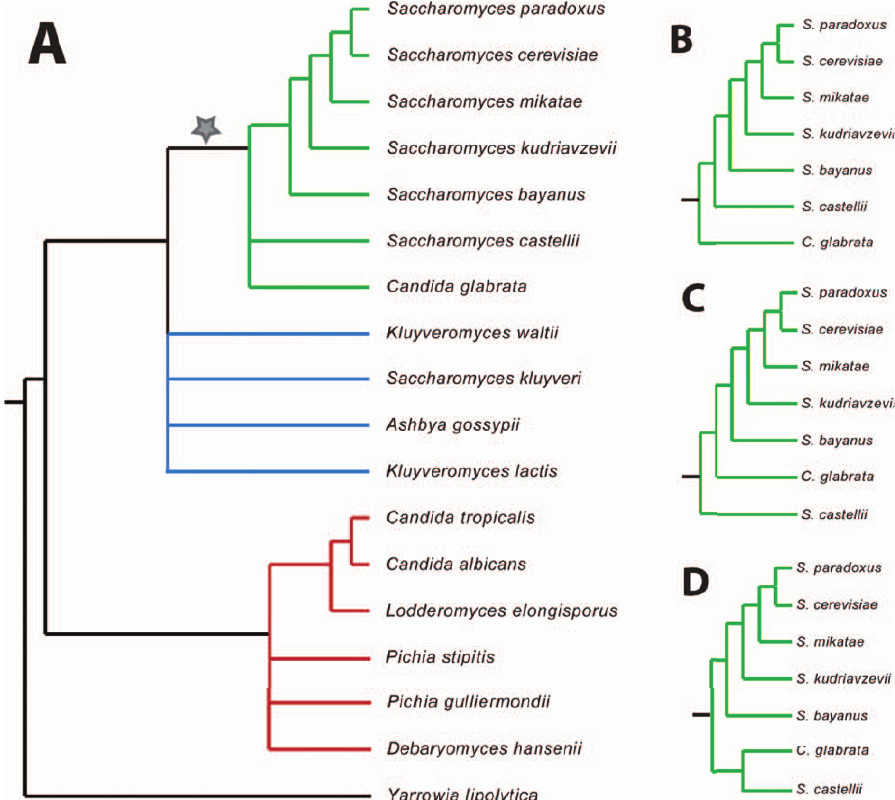
Figure 2. Species considered in this study and their phylogenetic relationships. A: ‘‘Backbone’’ species tree based on well-accepted phylogenetic relationships and secondary genomic features (see Methods). Branches colored in green indicate the post-WGD clade, blue the pre- WGD clade and red the CTG clade. B – D: Alternative resolutions recovered for the post-WGD clade.